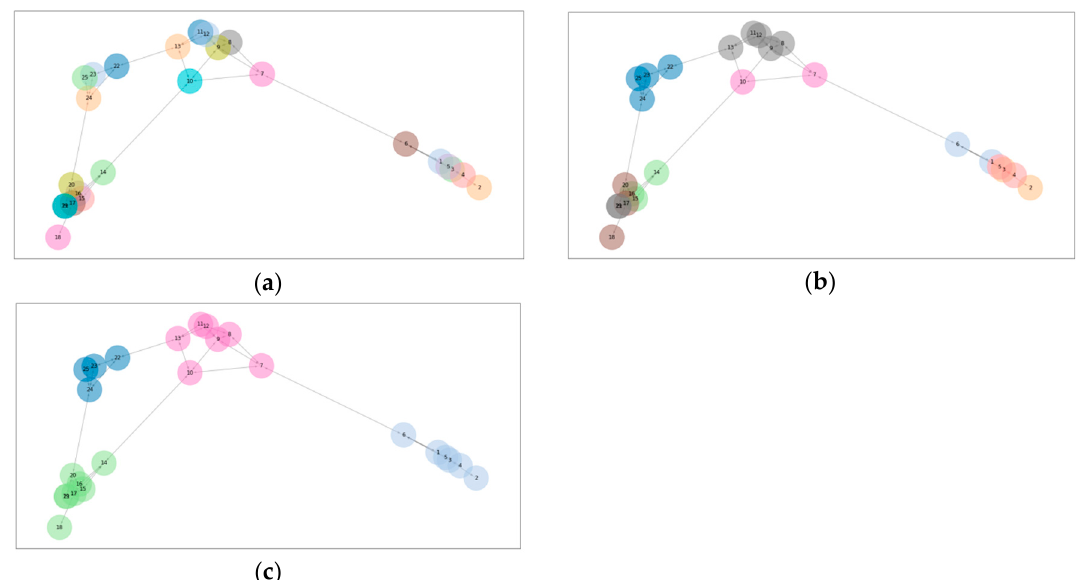
Figure 2. The same 25-node graph, showing all merges according to the InfoFlow algorithm. There are totally 2 loops, compared to 21 in InfoMap. ( a ) The initial graph is shown for easy reference; ( b ) after one loop, the 25 communities are merged into 9, which is roughly the geometric mean between 25 and 4; ( c ) The final partitioning is identical to that of InfoMap.